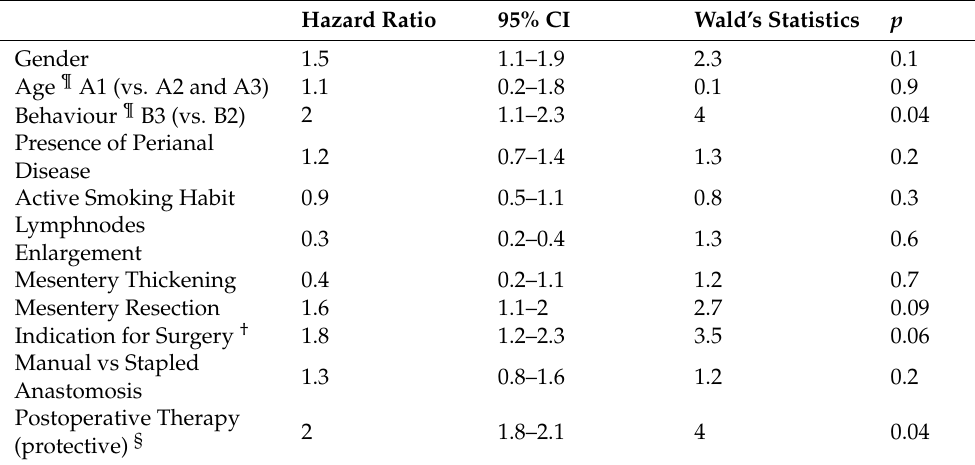
Figure 2. Kaplan and Meier time-to-event estimates of study general population ( a ), patients pre- senting mesentery thickening ( b ), patients treated with or without mesentery resection ( c ), and with biological or immunomodulator versus mesalamine therapy ( d ). Univariate analysis performed using the Log-Rank test. Cox’s proportional hazard regression model results are reported in Table 2. Perforat- ing disease Behavior (B3) resulted as a risk factor related to postoperative surgical recur- rence (HR 2, p = 0.04), while postoperative adjuvant treatment with biological or immu- nosuppressants showed a protective rule (HR 2, p = 0.04). Table 2. Multivariate analysis using the Cox’s proportional hazard model. ¶ Montreal Classification for CD. † Indication for fibro-stenotic or perforative disease. § Patients that completed postoperative induction regimen with a biological therapy or immunosuppressive drug and were able to maintain the treatment for at least 6 months or 1/3 of their follow-up duration, compared to other treatments.